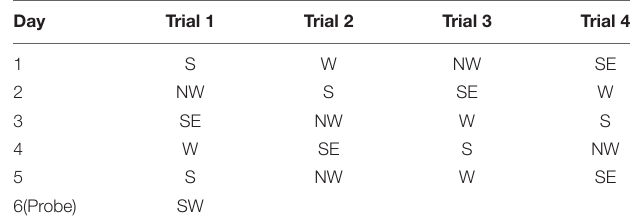
TABLE 1 | Start positions for the spatial and probe test of Morris water maze. TABLE 2 | Platform and start positions in spatial working memory.